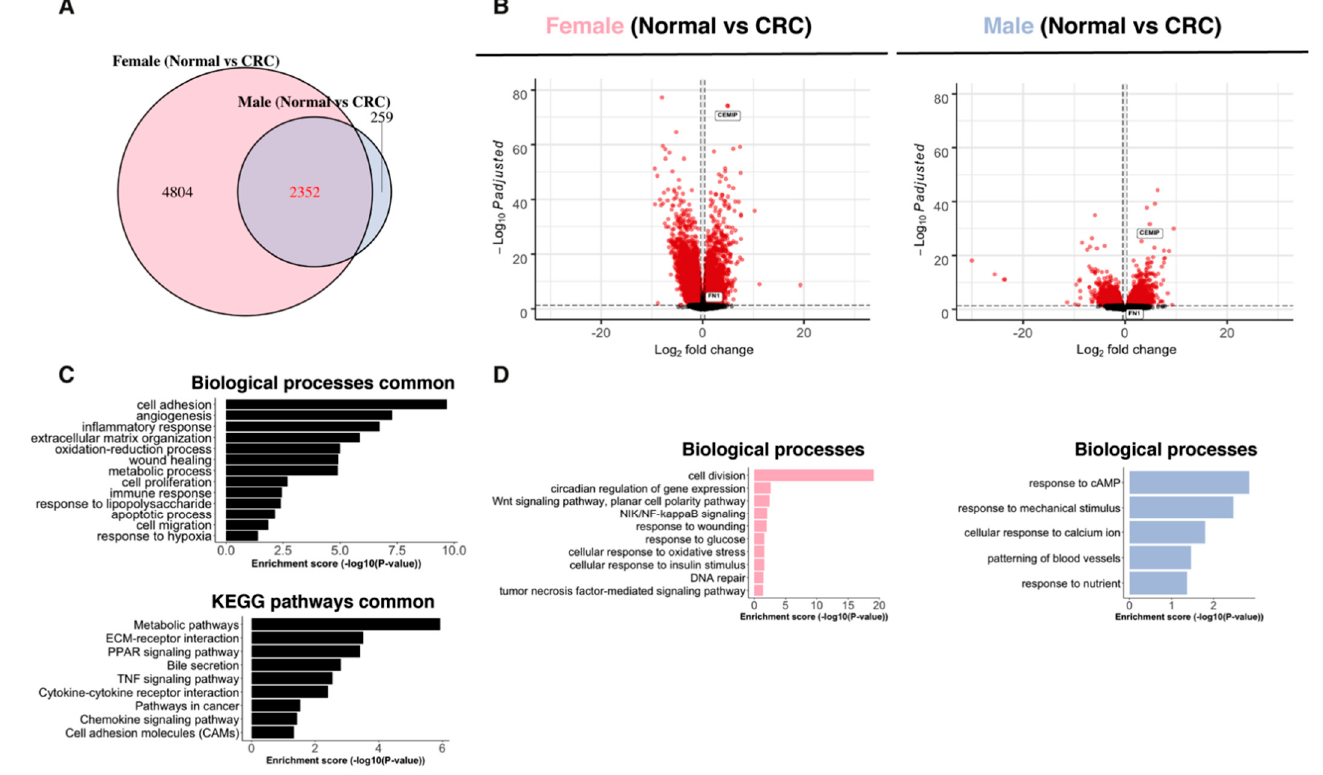
Figure 2. Sex-specific DEG in the tumors compared to paired normal samples. ( A ) Venn diagram comparing DEG between normal colon and CRC in females compared to males and ( B ) volcano plots of the DEG. ( C ) Biological process and KEGG pathway enrichment analysis on the DEG between normal colon and CRC in both sexes. ( D ) Biological process enrichment analysis on the sex-specific DEG between a normal colon and CRC.